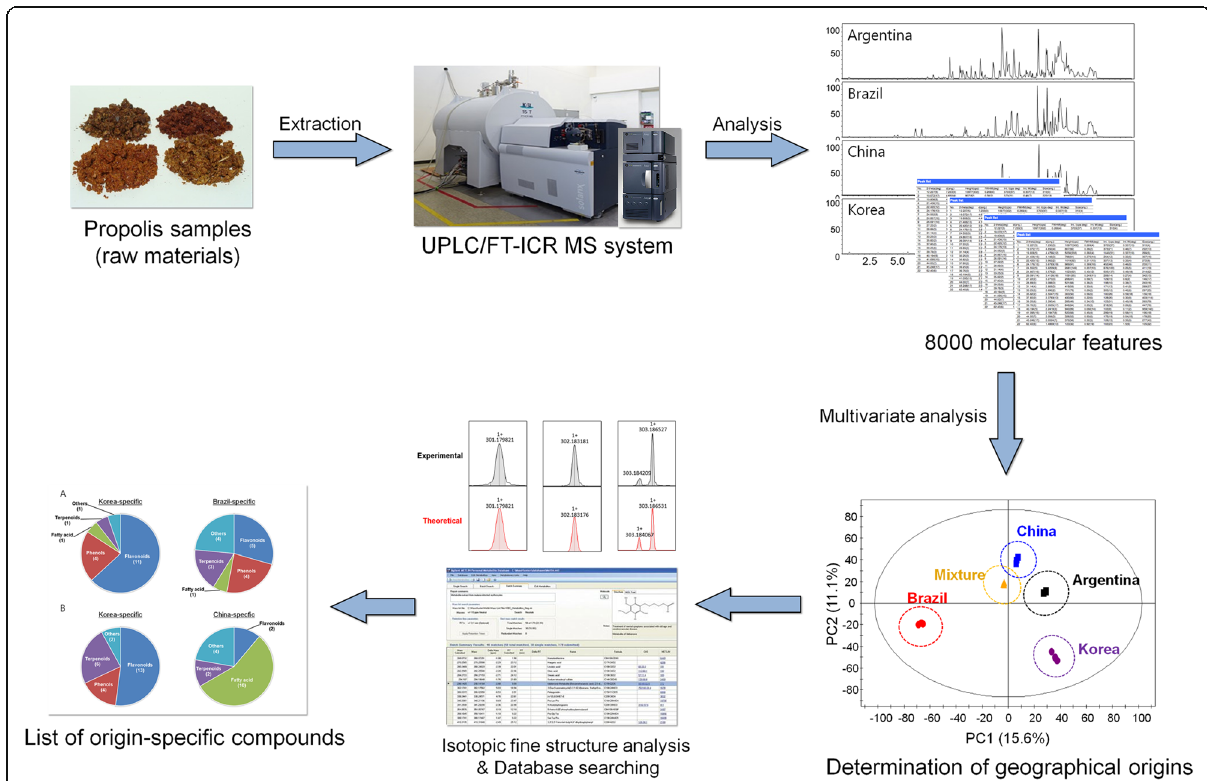
Fig. 1 Schematic workflow of UPLC/FT-ICR MS-based high-resolution analytical platform for determining the geographical origins of raw propolis